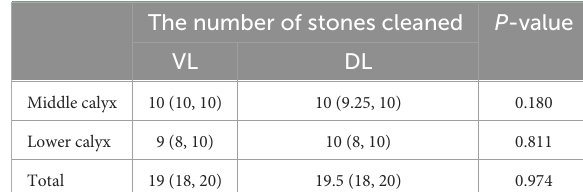
TABLE 3 Number of stones cleaned when the lower calyx (VL and the DL) was the targeted calyx. The number of stones